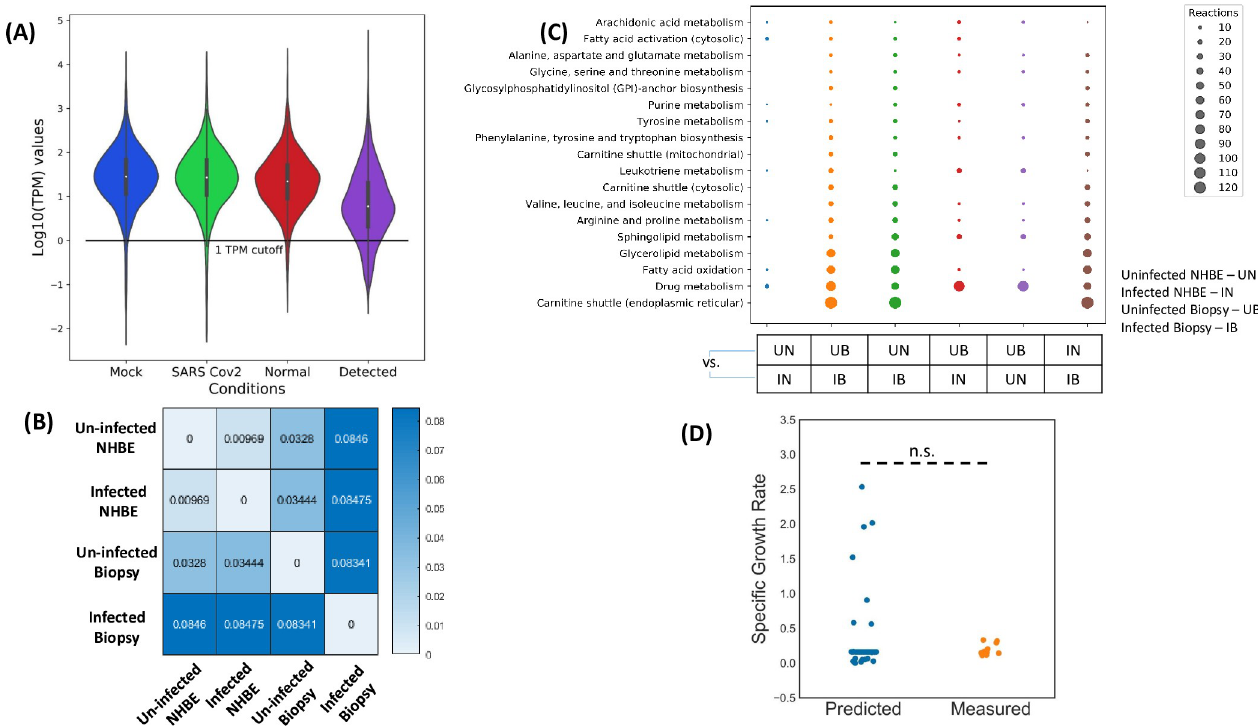
Fig 2. Generation of context-specific models of SARS-CoV-2 infected cells and normal cells using gene-expression data and tINIT algorithm. (A) The distribution of TPM normalized gene expression in Mock NHBE cells, SARS-CoV-2 infected NHBE cells, Normal Lung Tissue (From Biopsy) and Infected Tissue (From Biopsy). (B) The Hamming distance between all the generated context specific models based on the differences in reactions in the model. (C) The pathways over-represented while comparison between models. The reactions over-represented in each comparison are present exclusively in one of the models. (D) The agreement of model simulated specific growth rate of the virus with the experimental reported specific growth rate. n.s. stands for non- significant differences as estimated by t-test. The model simulated growth rate was calculated under ± 5% uncertainty in biomass composition and uptake rates. The experimental growth rates were derived from Bojkova et al. (Nature),